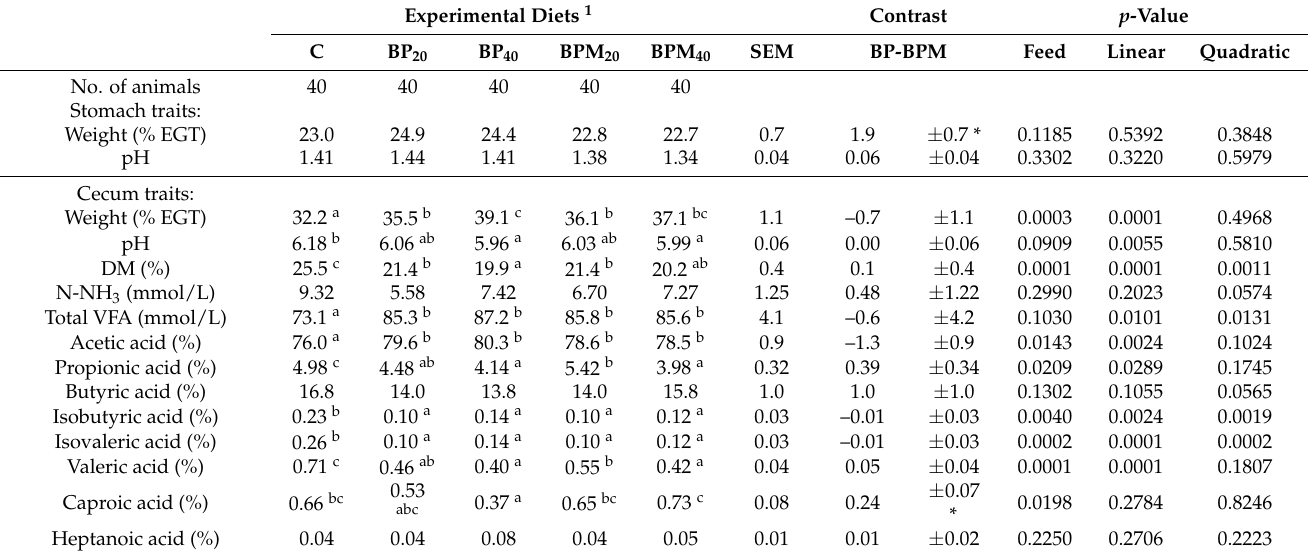
1 Experimental diets: C, control without beet pulp; BP 20 , with 20% of beet pulp without molasses; BP 40 , with 40% of beet pulp without molasses; BPM 20 , with 20% of beet pulp with molasses; BPM 40 , with 40% of beet